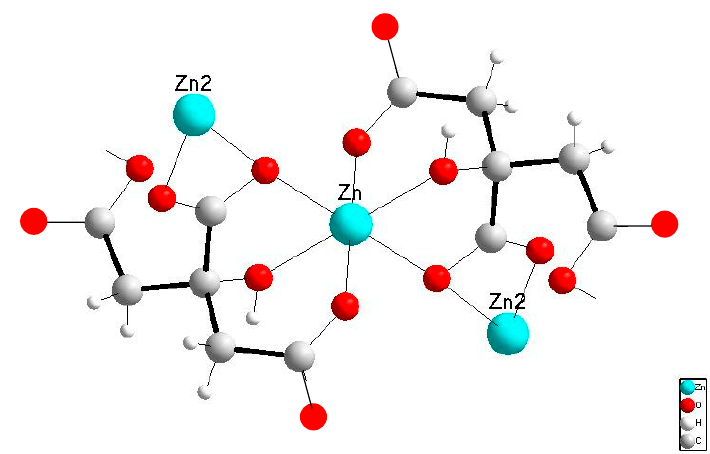
Figure 1. Molecular diagram of 1 .